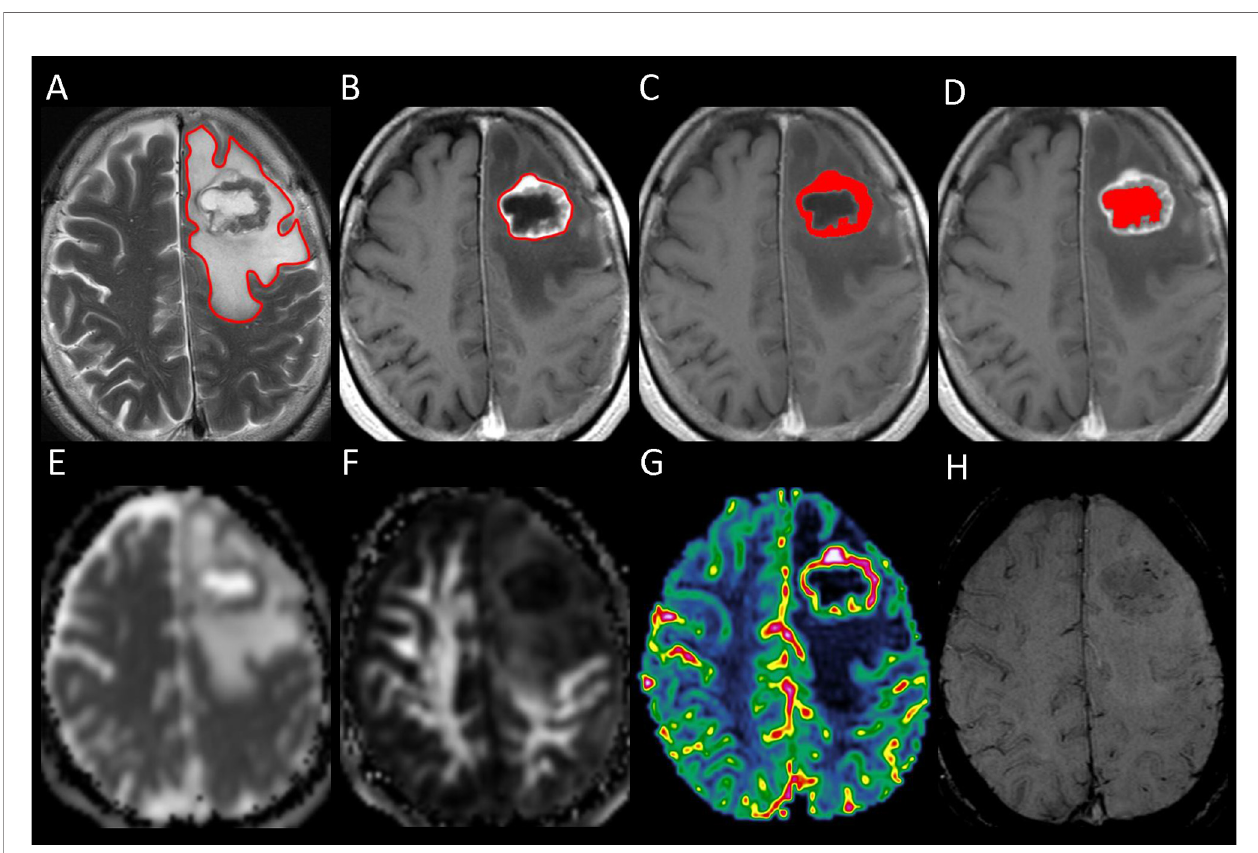
FIGURE 1 | Example of how regions of interest (ROIs) were segmented in a left frontal metastatic brain tumor. Transverse T2-weighted image (A) shows a manually drawn polygonal ROI that includes the entire peritumoral brain edema and the whole tumor. On contrast-enhanced T1-weighted images (B – D) , the ROIs of whole tumor (B) , enhancing tumor (C) , and necrotic portion (D) are shown. The ROI of the enhancing tumor (C) is used to measure the tumor apparent diffusion coef fi cient (ADC), tumor fractional anisotropy (FA), and tumor cerebral blood volume (CBV) by overlaying the ROI on the corresponding ADC (E) , FA (F), and CBV (G) maps. On susceptibility-weighted image (H) , there is no hemorrhagic tumor